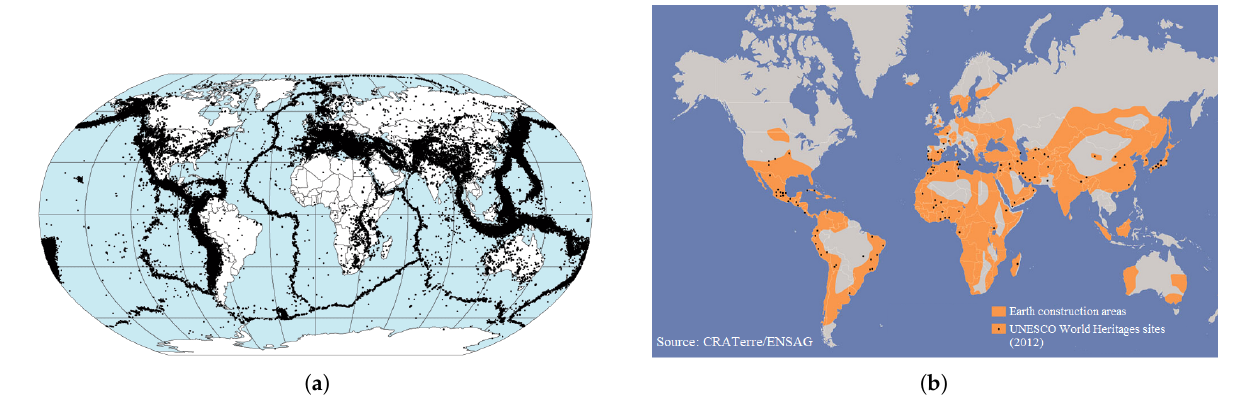
Figure 1. ( a ) Earthquake epicentres in world from 1963 to 1998 (NASA, DTAM project team); ( b ) distribution of earthen constructions (Auroville Earth Institute, UNESCO Chair Earthen Architecture. Buildings with Earth Technique overview, 2012) [22].